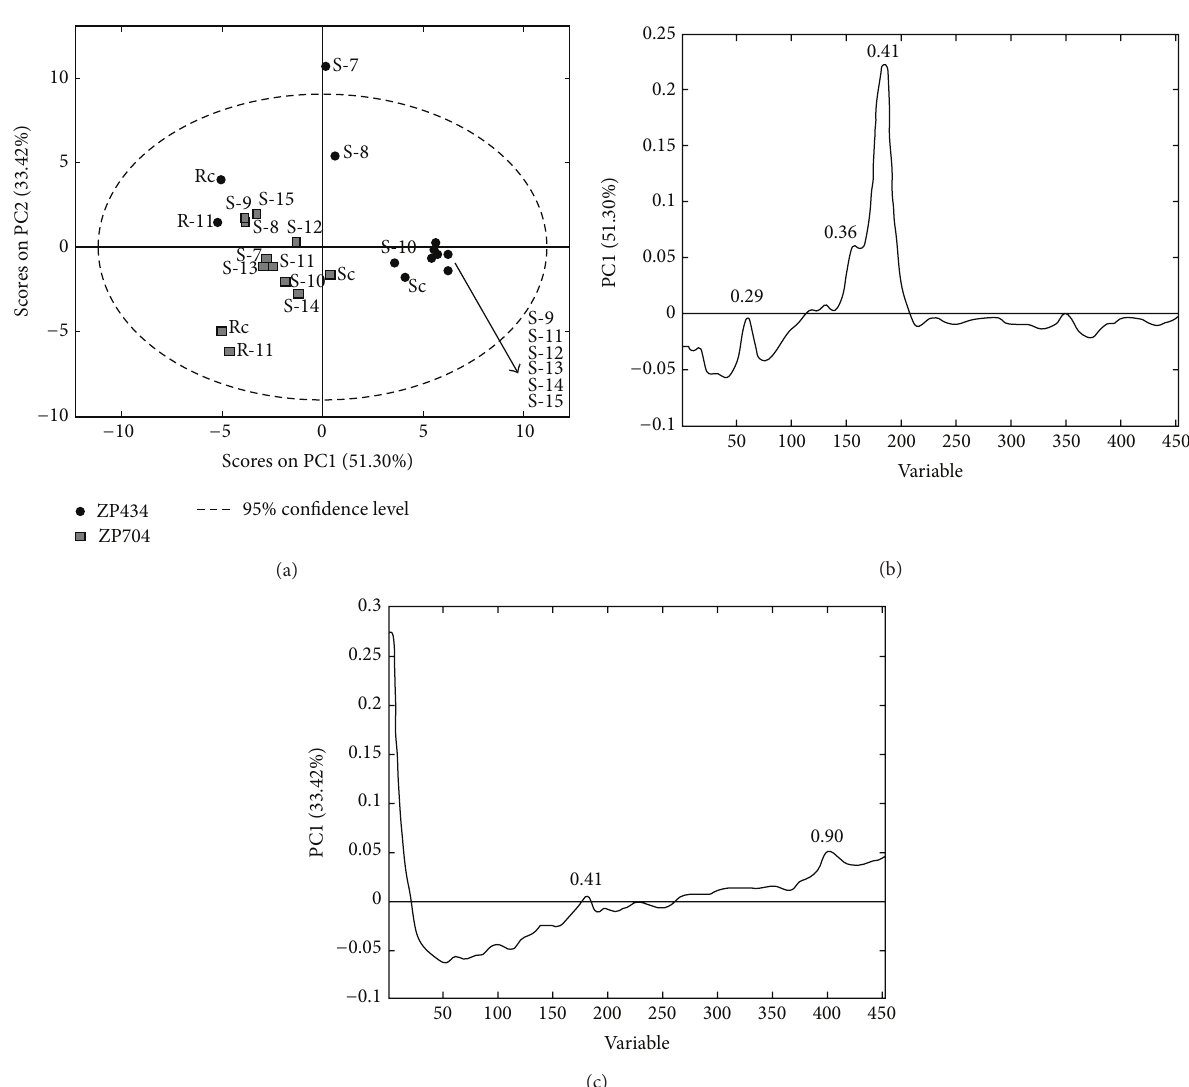
Figure 5: PCA analysis performed on data obtained in CS2, (a) mutual projections of factor scores, and (b, c) loadings for the PC1 and PC2, respectively, for a model corresponding to blue channel. Labels on score plot correspond to those in Table